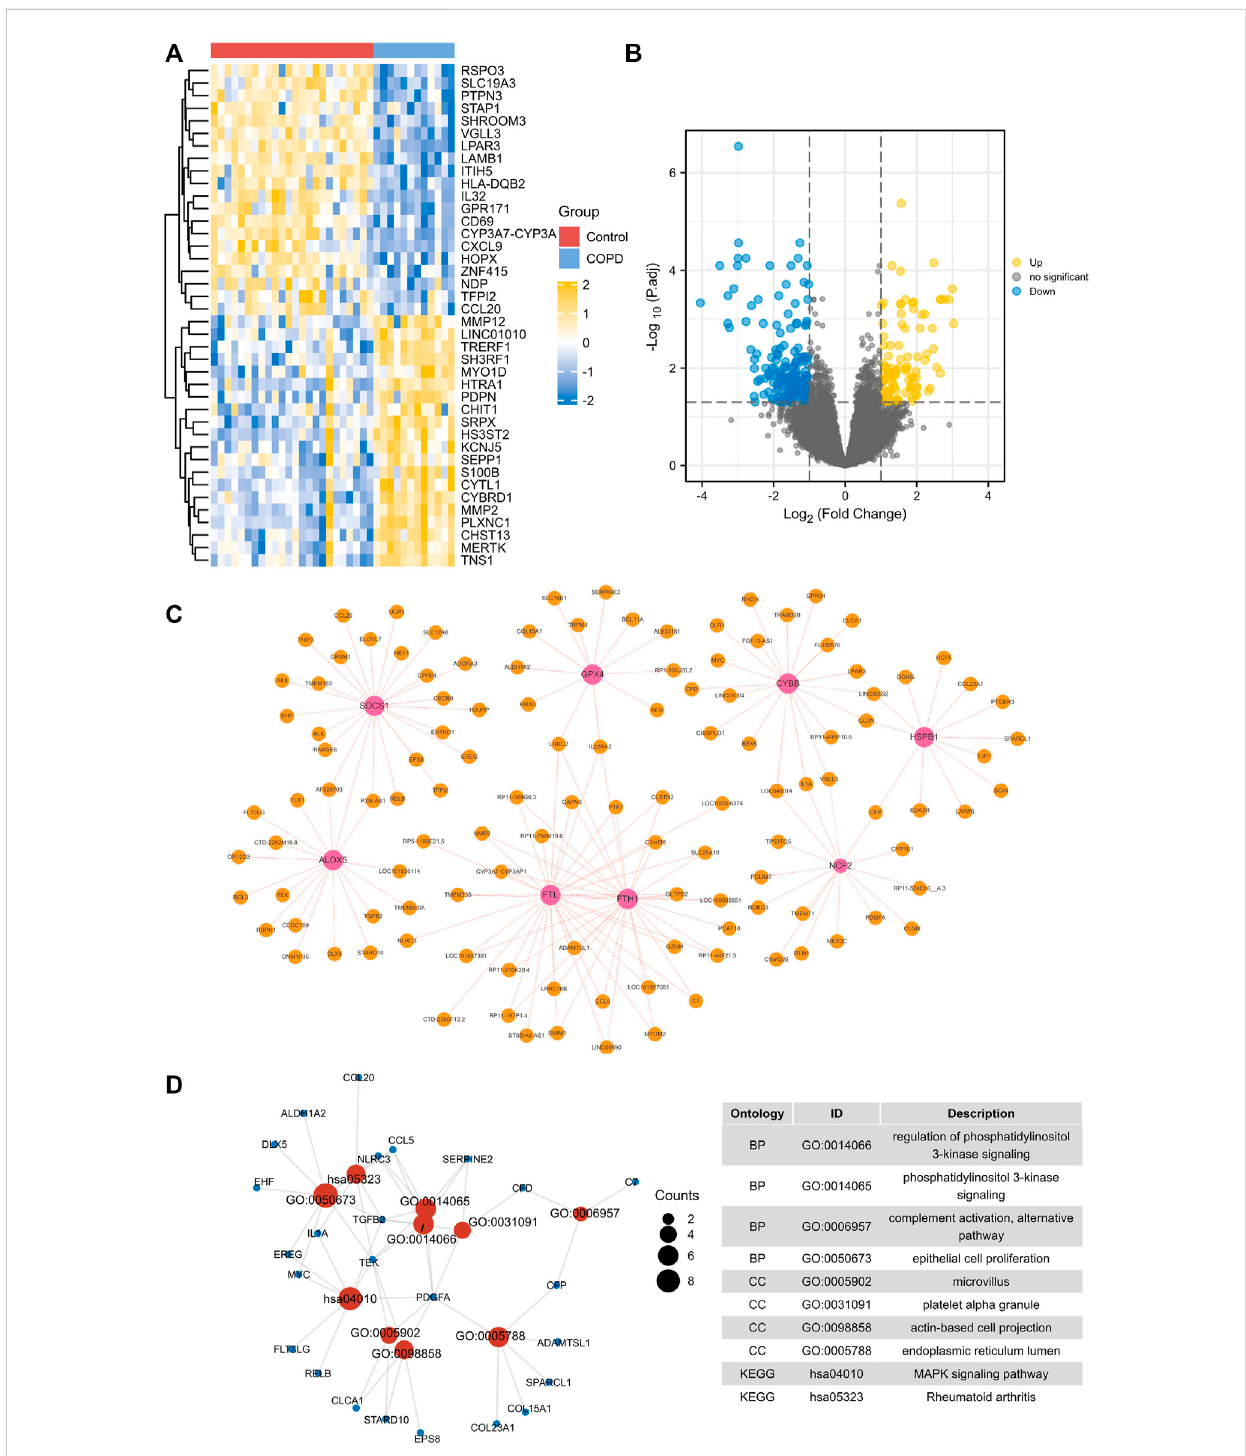
FIGURE 4 Identi fi cation and enrichment analysis of macrophage ferroptosis-related DEGs. (A,B) heat maps and volcano maps of GSE13896. (C) Macrophage ferroptosis related genes and DEGs interaction network. (D) GO and KEGG pathways enriched by the macrophage ferroptosis-related DEGs.